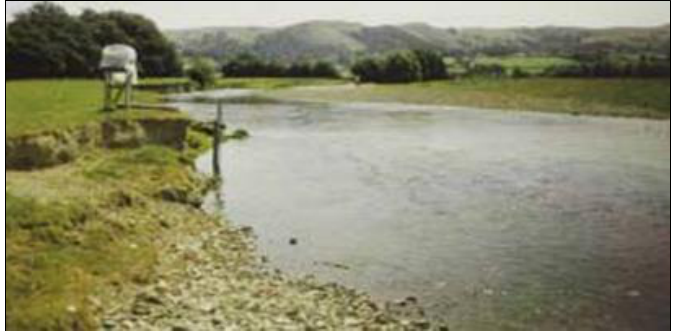
Figure 15: Aspects of the River Severn (Caersws, Wales).